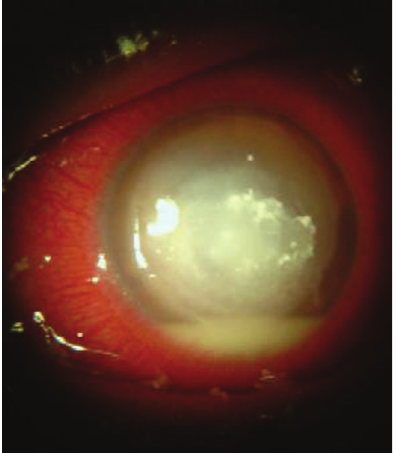
Figure 1: Three weeks after initial presentation, corneal ulcer associated with an intense inflammation and a dense hypopyon were still observed.